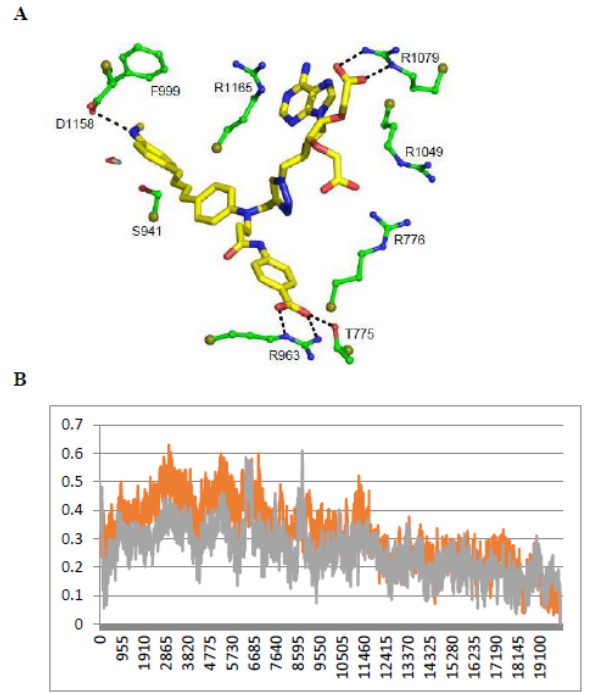
Figure A3. Stability of the 2 carboxylates of NT3_3: ( A ) Structure at 10 ns with only one carboxylate bound; ( B ) the fluctuations of the carboxylates: the 2’ (orange) and 3’ (grey) carboxylate of NT3_3 were quantified by the root mean square deviation (RMSD in Ǻ ) during 20 ns of dynamics.